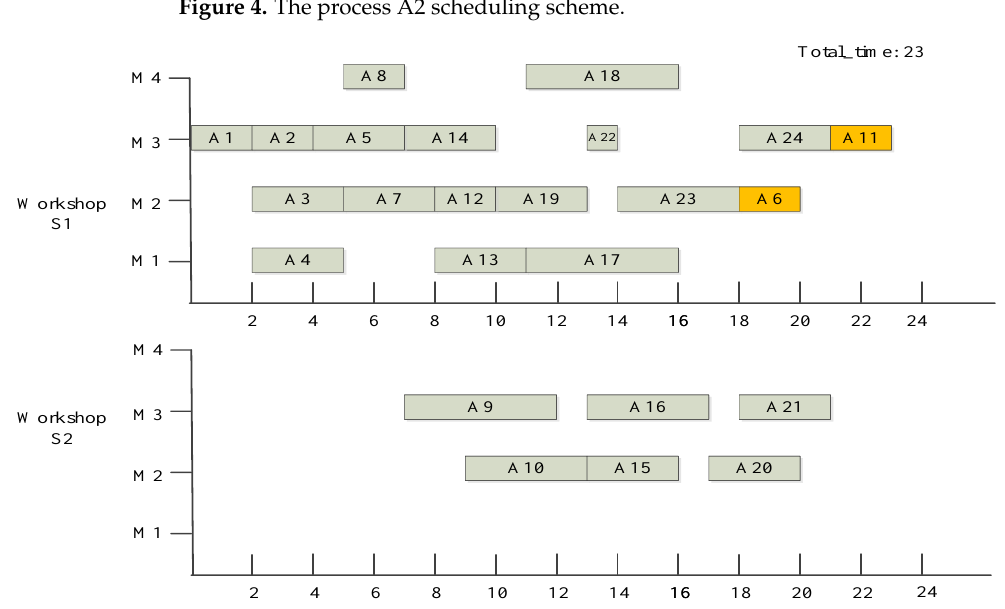
Figure 4. The process A2 scheduling scheme.